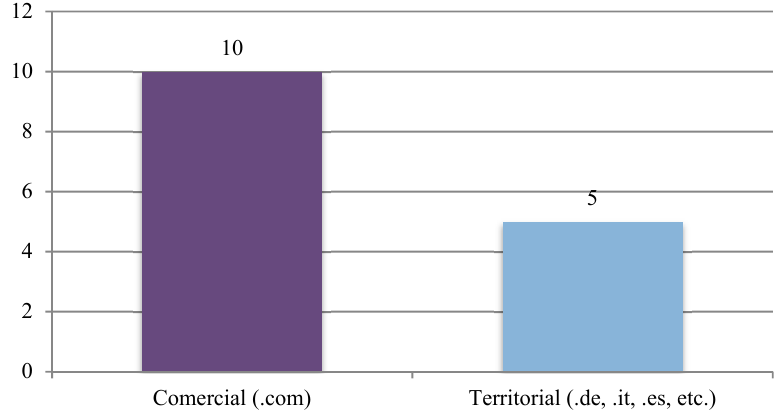
Figure 2. Domain extension. Source : elaborated by the authors.